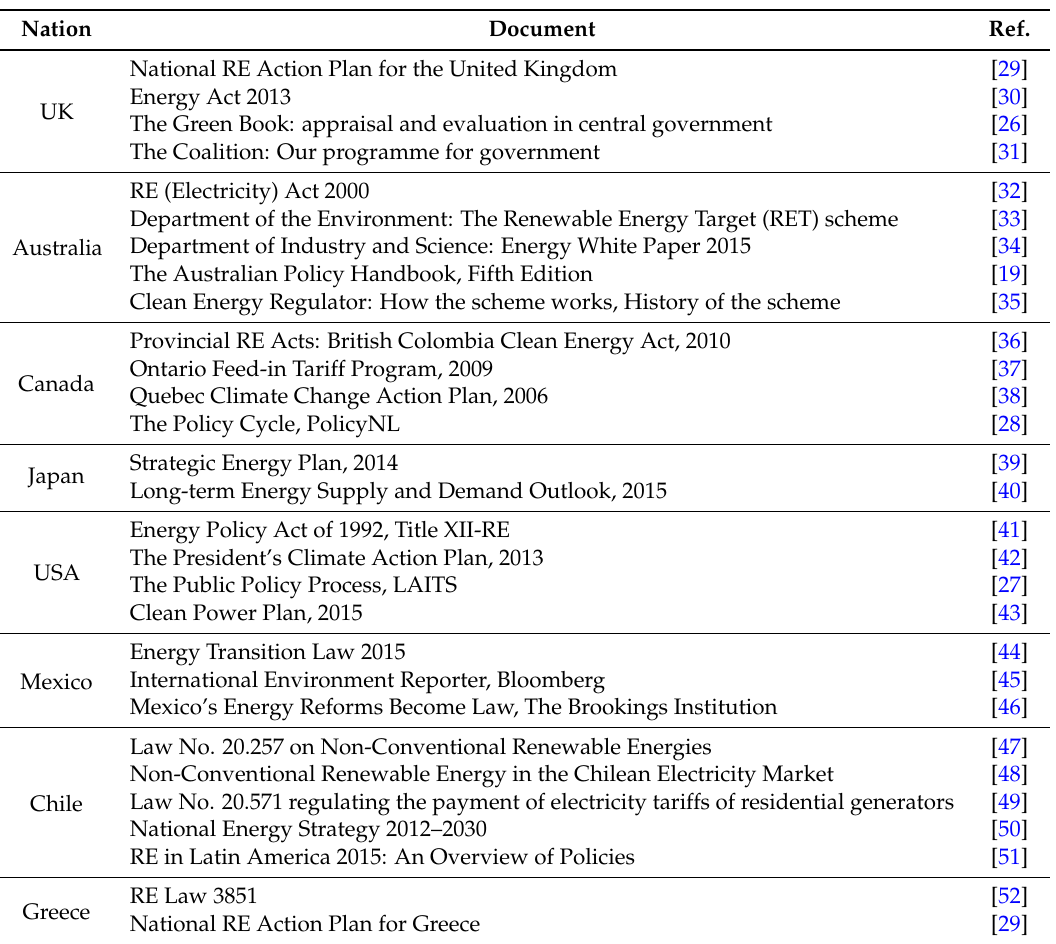
Table 4. Assessed government and supporting documents.